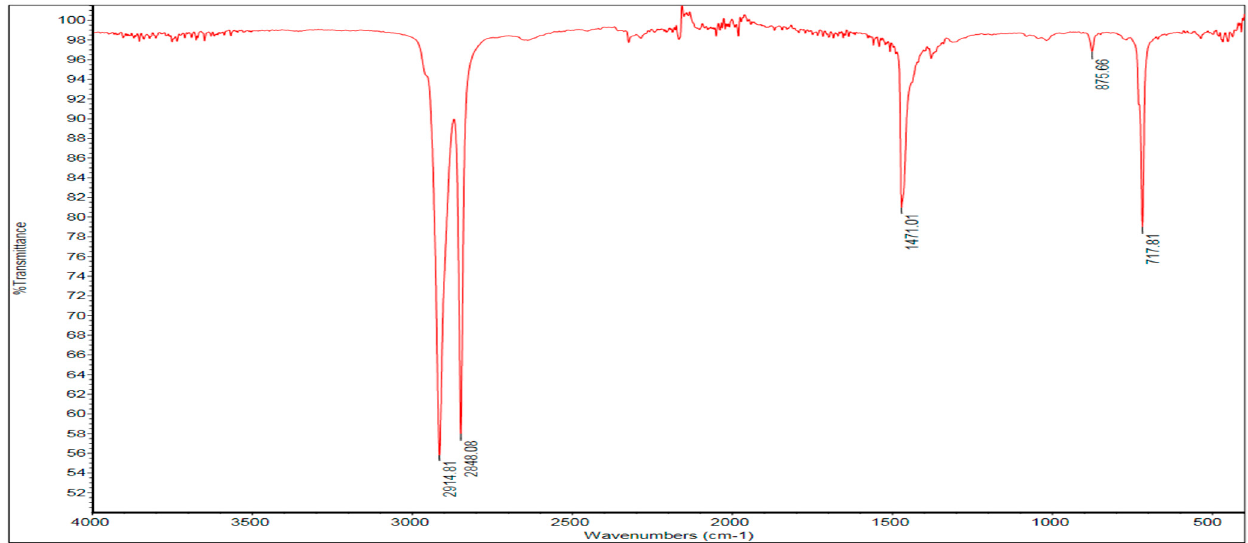
Figure 13. FTIR analysis of LLDPE after the addition of 3% weight pro-oxidant additive at day 7.